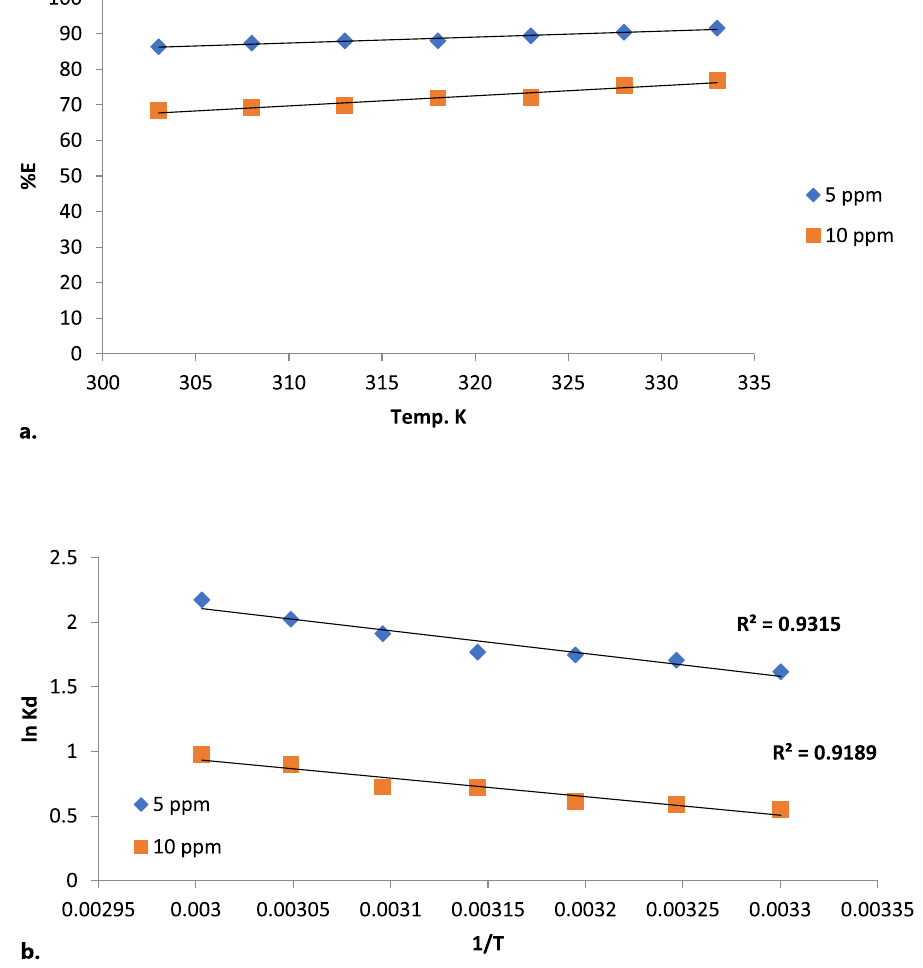
Figure 10. ( a ) Influence of temperature on biosorptive removal of BF dye by Gel@GO-F-ZrSiO 4 @Gel. Removal efficiency values (%) are based on triplicate analysis with ± 0.3–1.0%. ( b ) Vant Hoff plot for biosorptive removal of BF dye by Gel@GO-F-ZrSiO 4